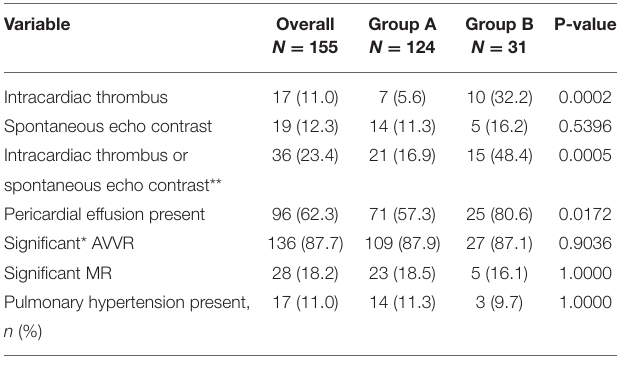
TABLE 2 | Comparison of selected echocardiographic features of the two cohorts of cases.